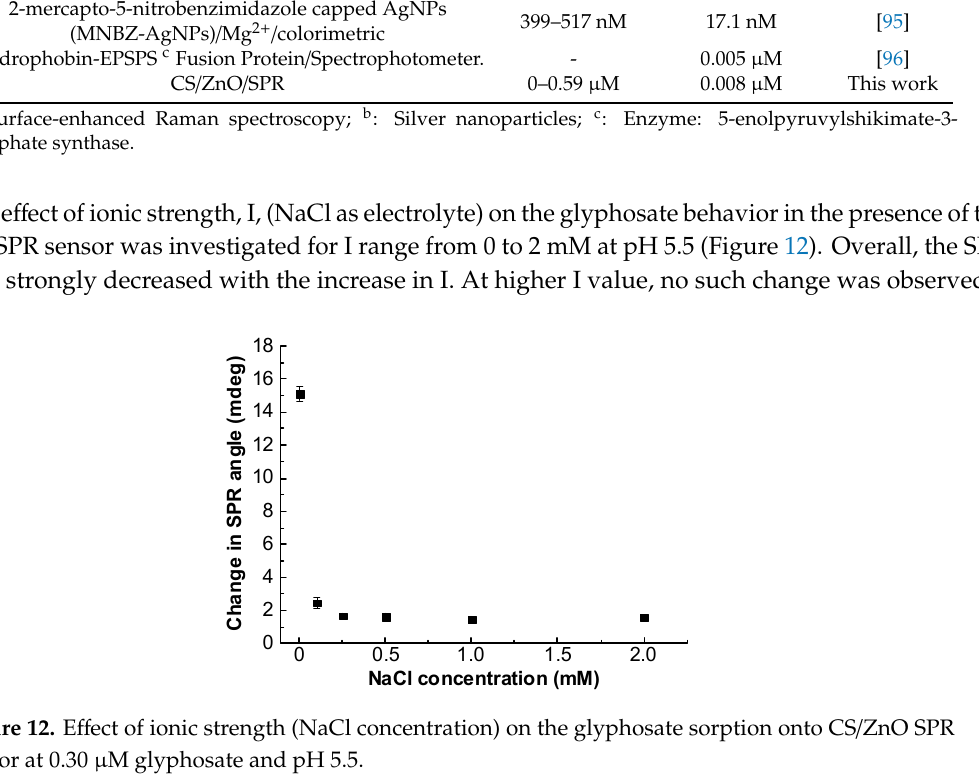
Table 1. Comparison of the CS/ZnO sensor with other optical methods for glyphosate detection.